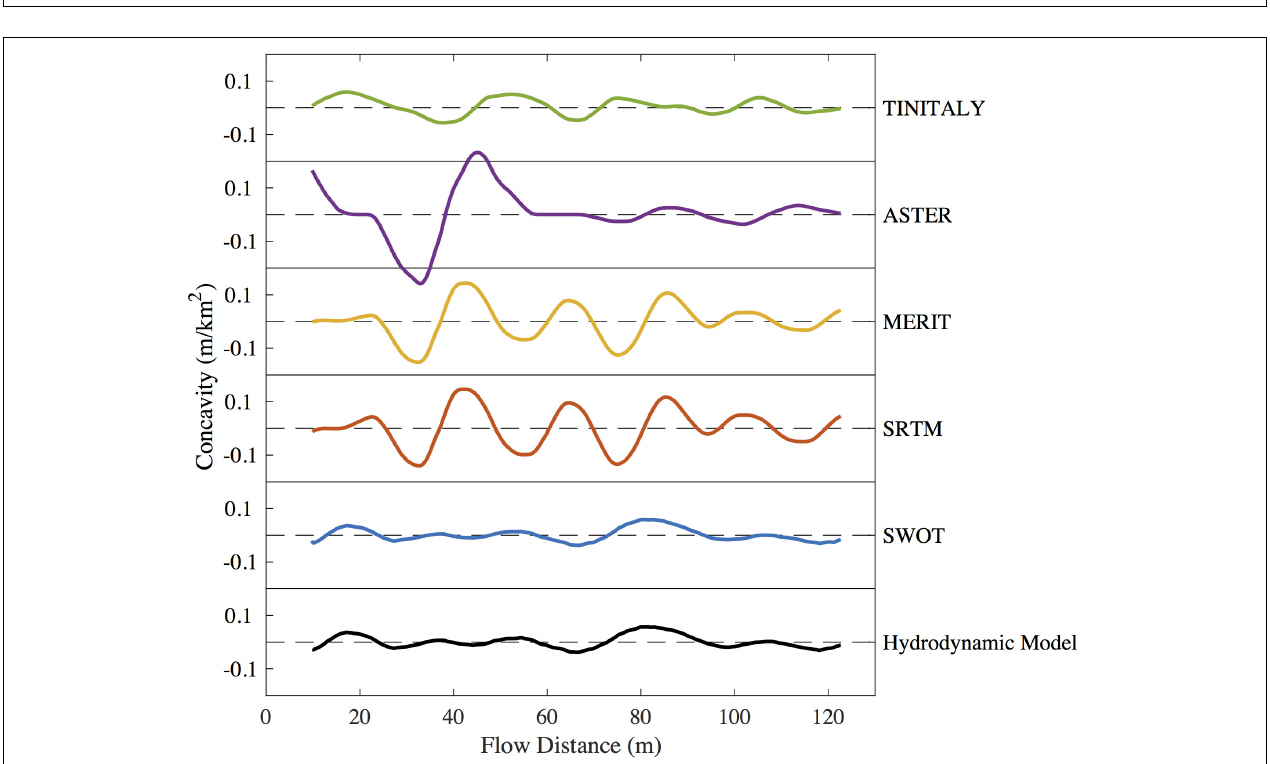
FIGURE 8 | (A) Smoothed average SWOT profile of the Po River colored by curvature. The elevation profile was smoothed using a 10 km mean window, and curvature calculated using a 20 km window. (B) Po River centerline plotted on top of the structural geology of the Po Plain (http://portalesgi.isprambiente.it/) with the same concavity color scale from (A) . The epicenters of two large earthquakes in 2012 are plotted in red.